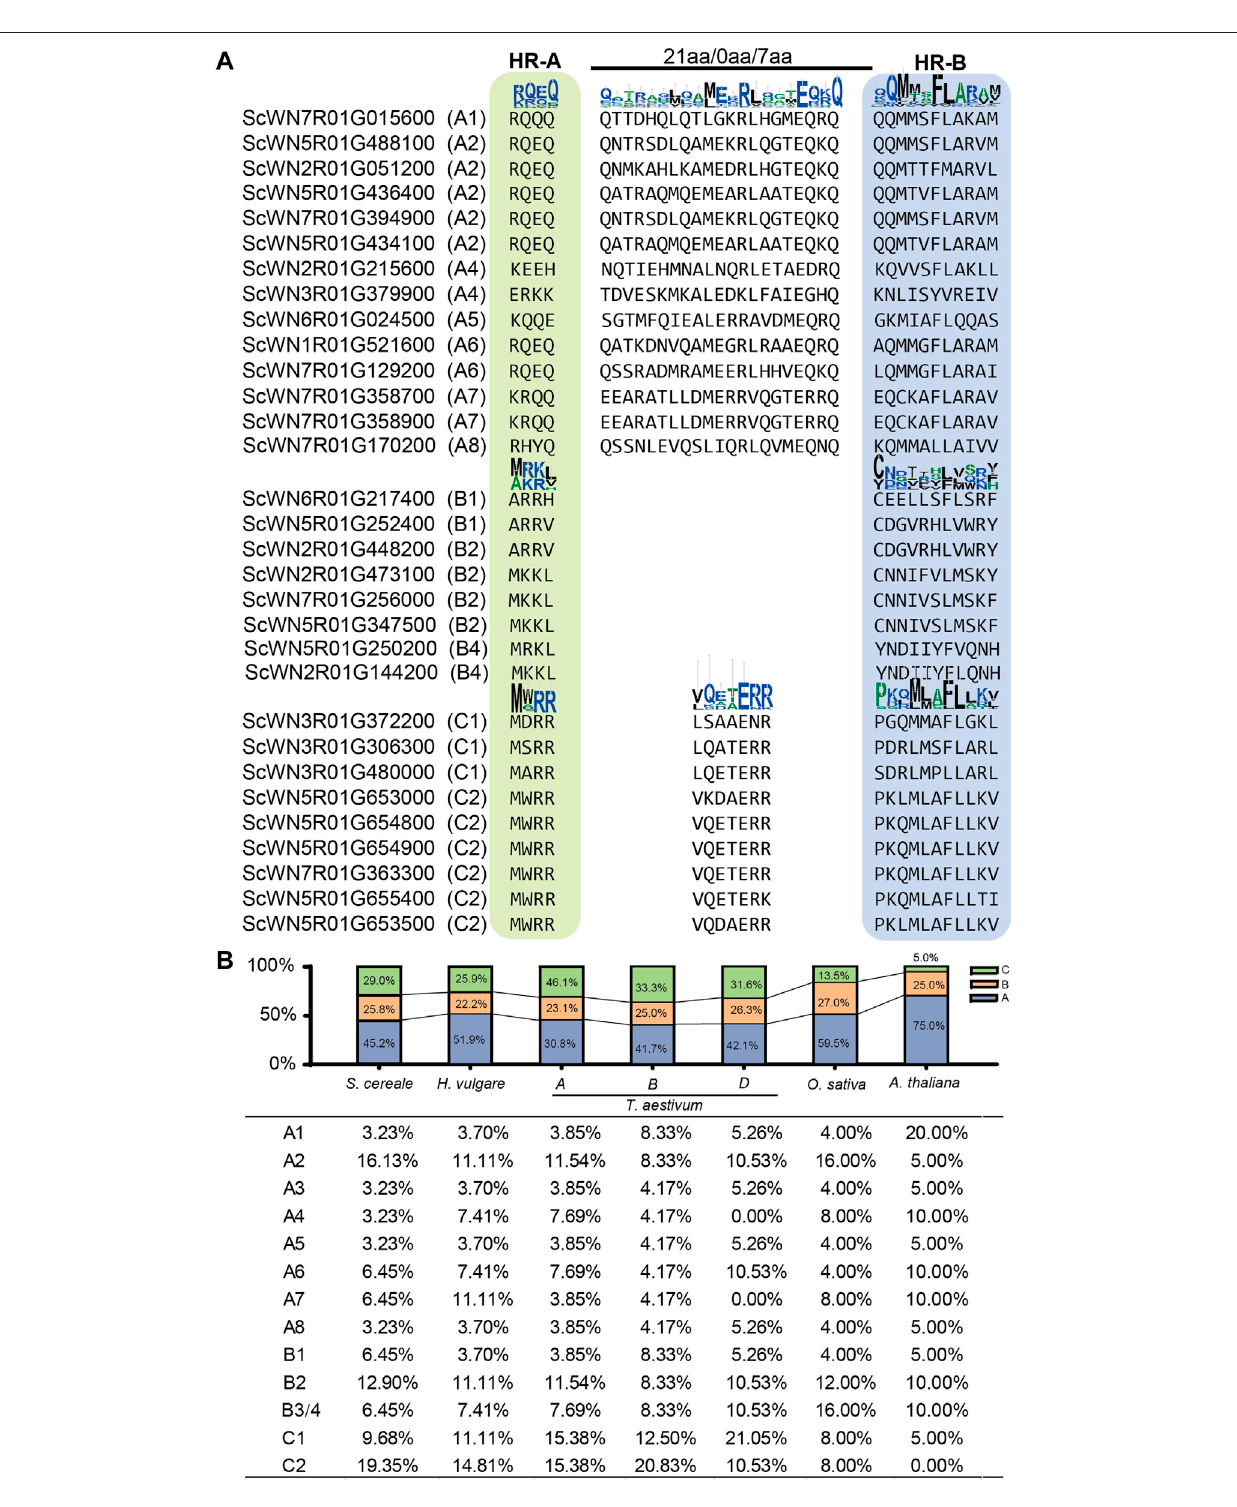
Frontiers in Genetics |